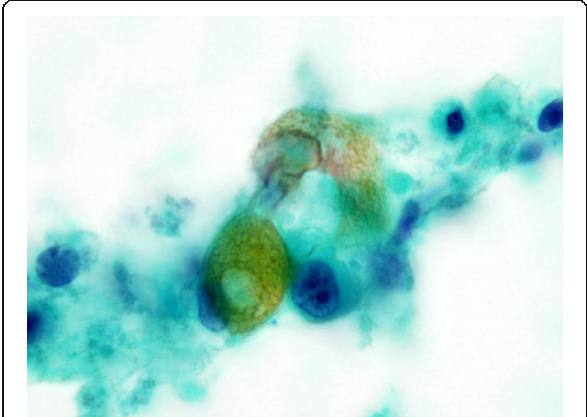
Fig. 5 Fine-needle aspiration (FNA) cytology of the left parotid region. Shadow cells with nuclear disappearance were found. Keratin fibers were seen in the cytoplasm of the shadow cells (Papanicolaou staining, ×